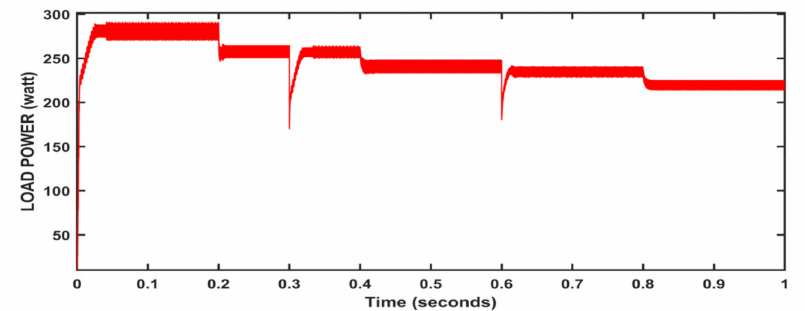
Figure 12. Algorithm performance at variable temperatures and variable loads; w = 1000 W/m 2 .